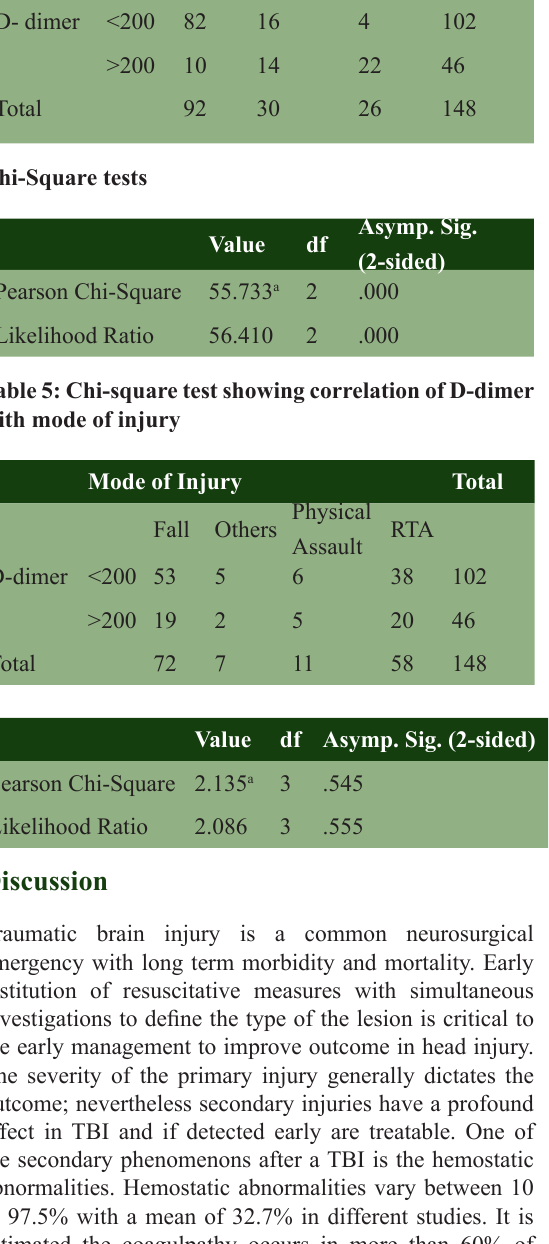
The severity of the primary injury generally dictates the outcome; nevertheless secondary injuries have a